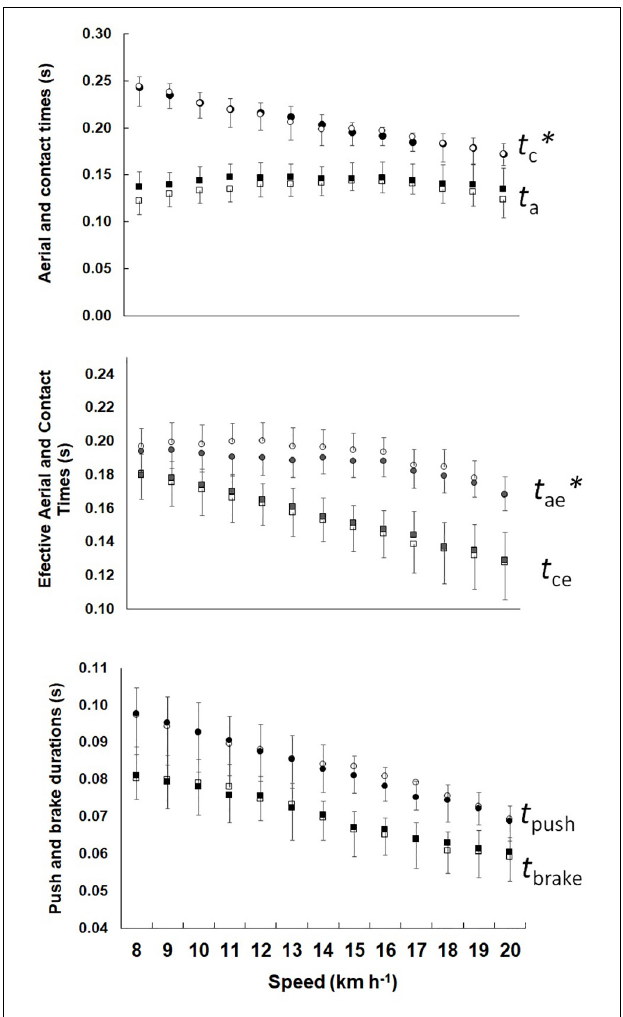
FIGURE 2 | Mean and standard deviation in aerial and contact times, effective aerial, and contact times, t push and t brake durations plotted as a function of the speed. Left show P high and right P low . The ∗ represents significant difference between the groups.